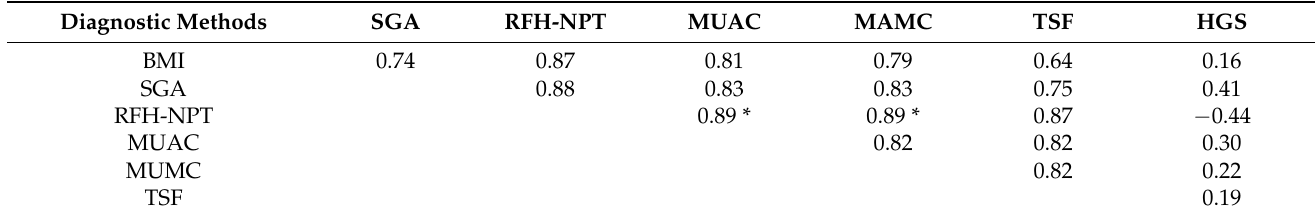
Table 4. Diagnostic accuracy of several models in the assessment of